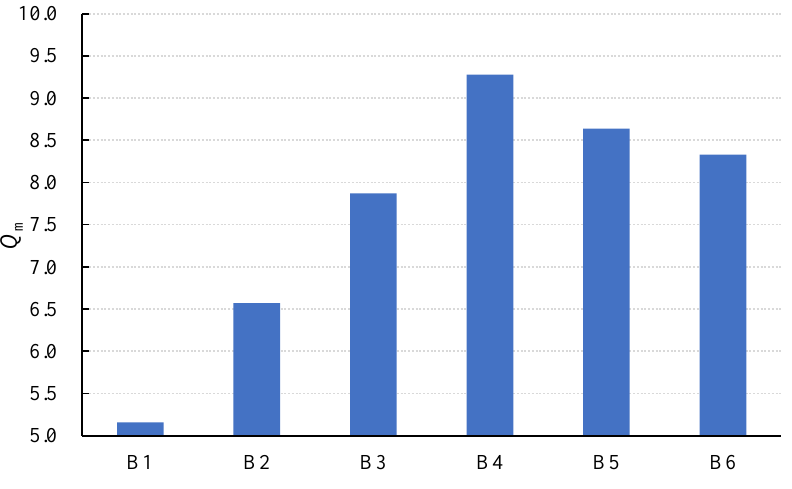
Figure 13. Mechanical quality factor.